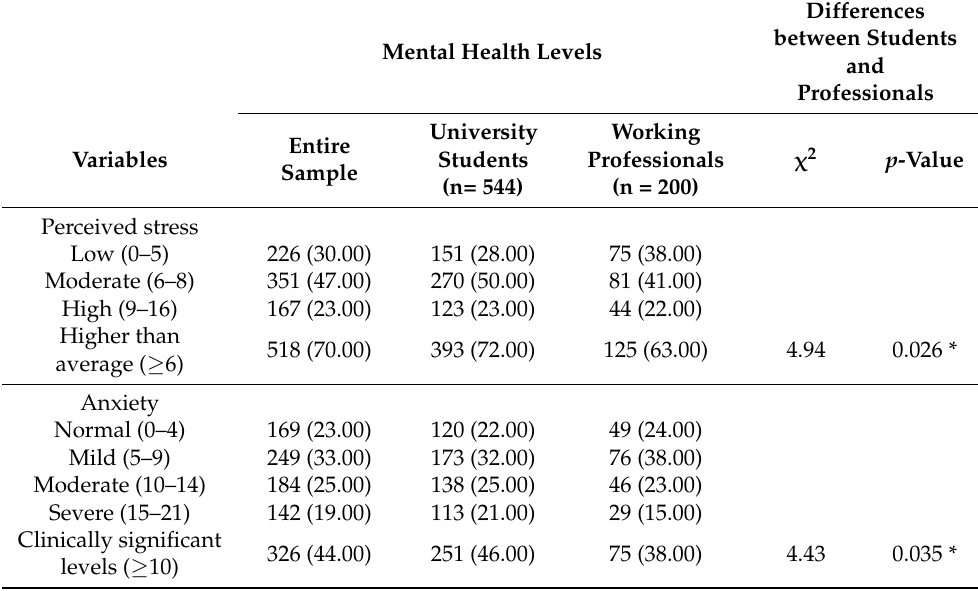
Differences between Students and Professionals